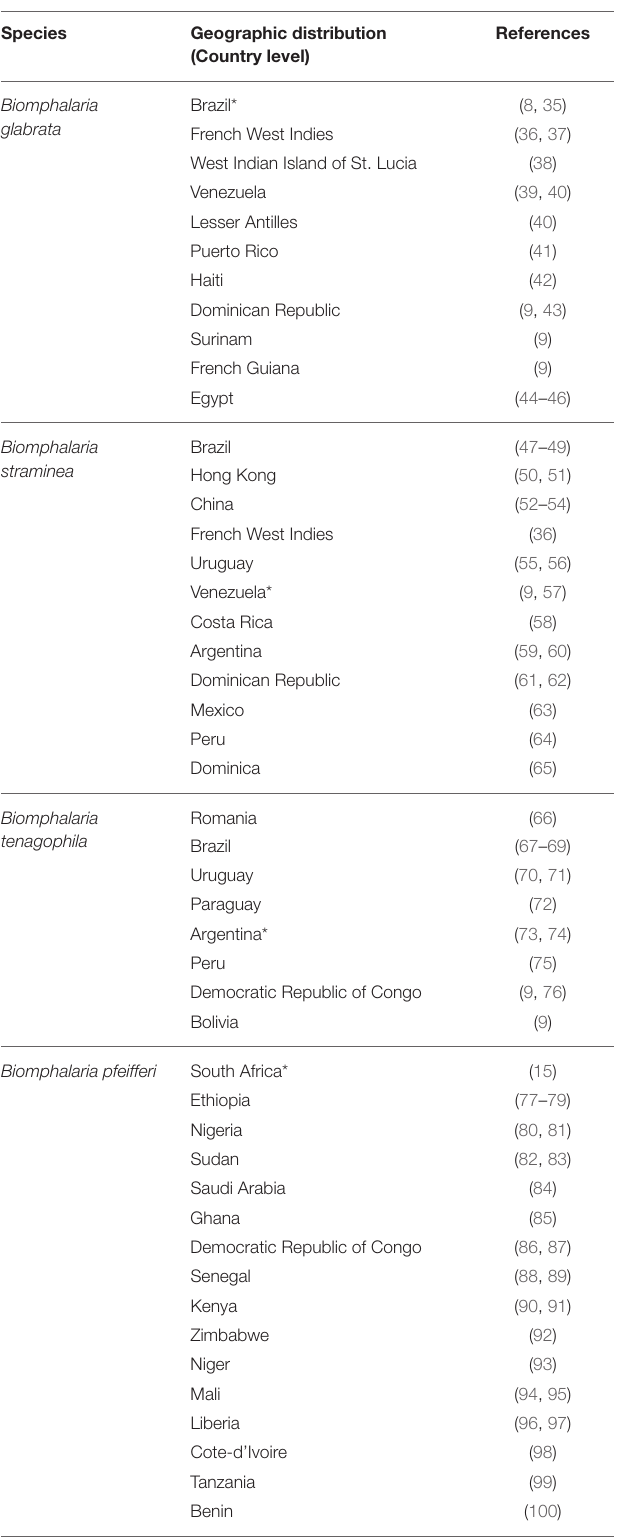
TABLE 1 | Distribution of naturally susceptible species of Biomphalaria . Species